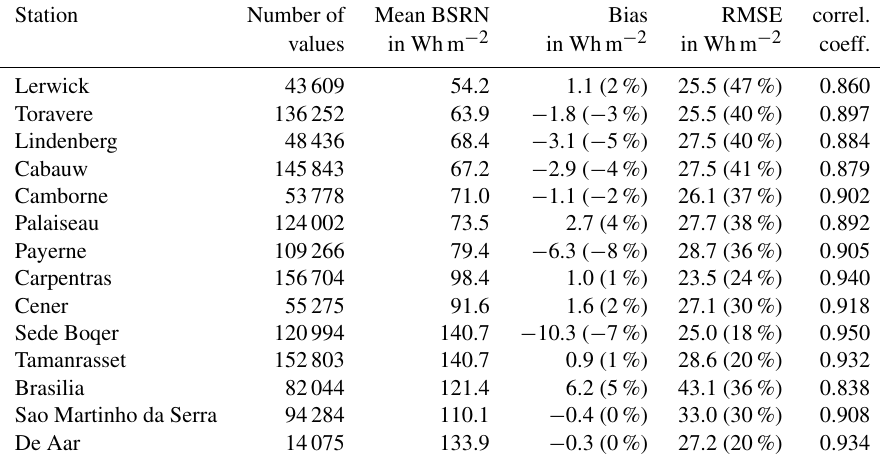
Table A2. Validation results for the 15min GHI for a temporal horizon of 1h. In parentheses, relative